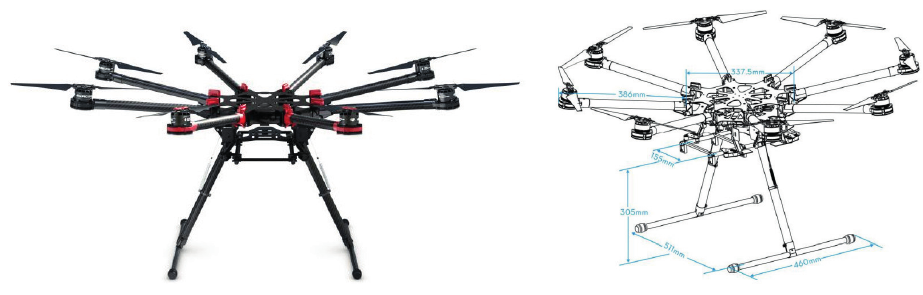
Figure 7. Drone DJI Spreading Wings S1000.